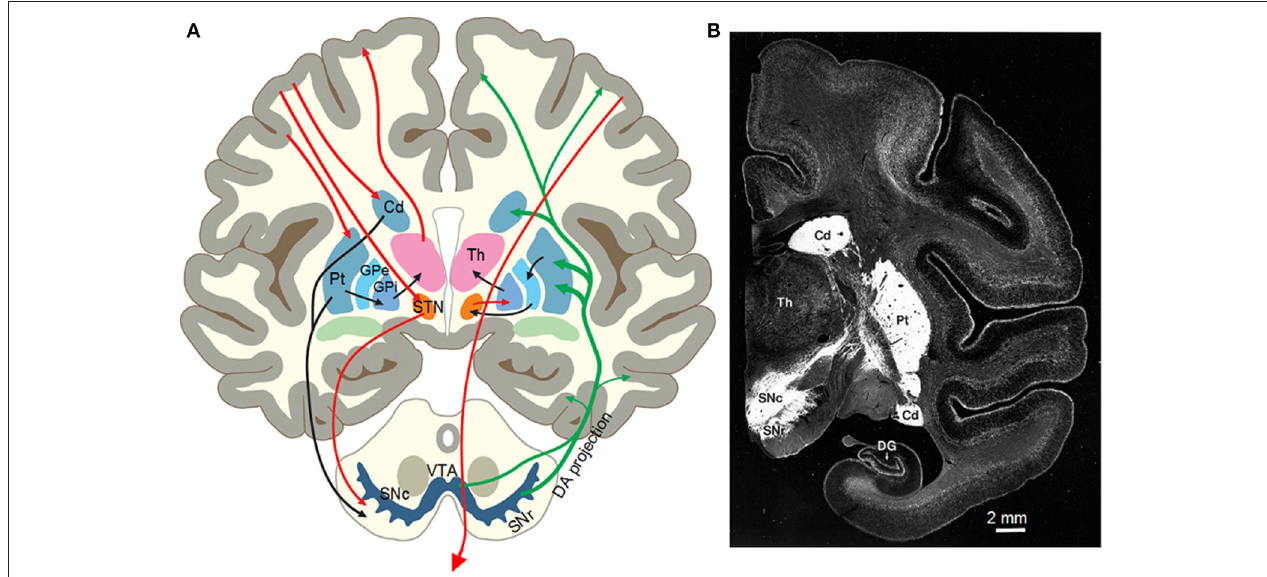
FIGURE 2 | (A) Diagram of the nigrostriatal system and the basal ganglia circuitry of the human brain. From Zhou et al. (2003) with permission. (B) Photograph of a monkey brain coronal section showing the intense DA innervation in the striatum (the putamen and the caudate nucleus) indicated by DAT immunostain. Modified from Lewis et al. (2001) with